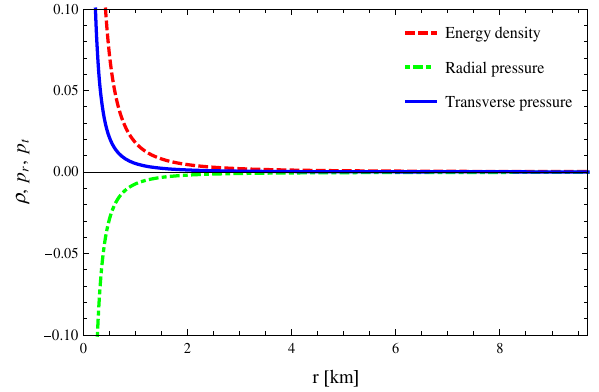
Fig. 1 Variation of the gravity profile, g ( r ) , with the radial coordinate when γ = + 0 . 9 and γ = − 0 . 2 for spherical object PSR J1614-2230 For our choice, α 1 = 0 . 45, max